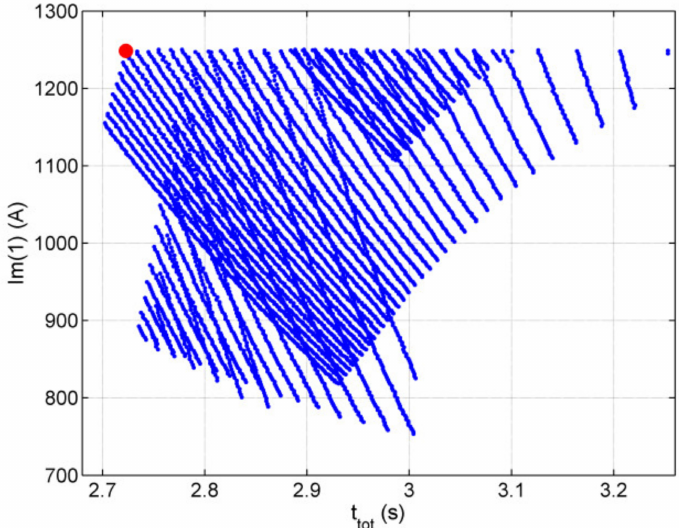
Figure 17. The relationship between the first peak value of the charging current and the total charging time for all feasible solutions of the Enumeration